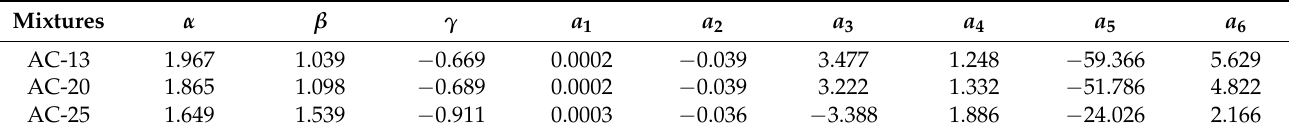
Table 8. The calibrated model parameters.